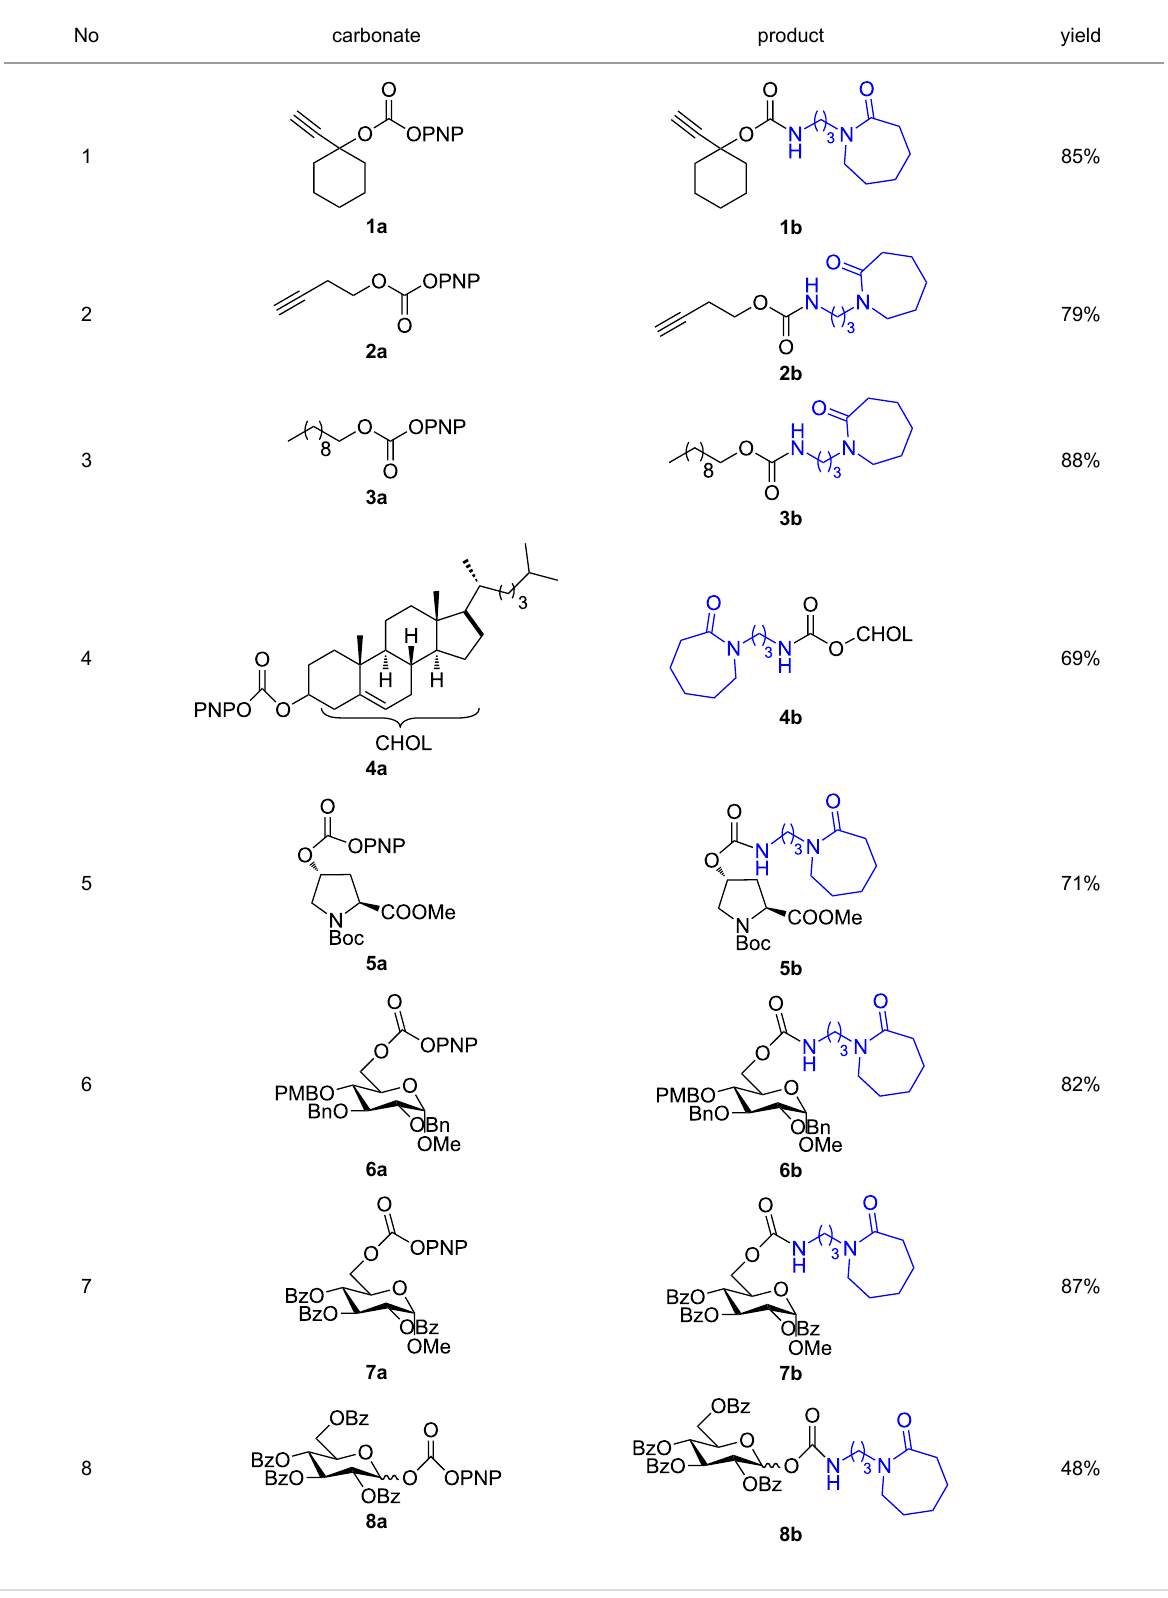
Table 1: Synthesis of ε -caprolactam-derived carbamates 1b–8b .